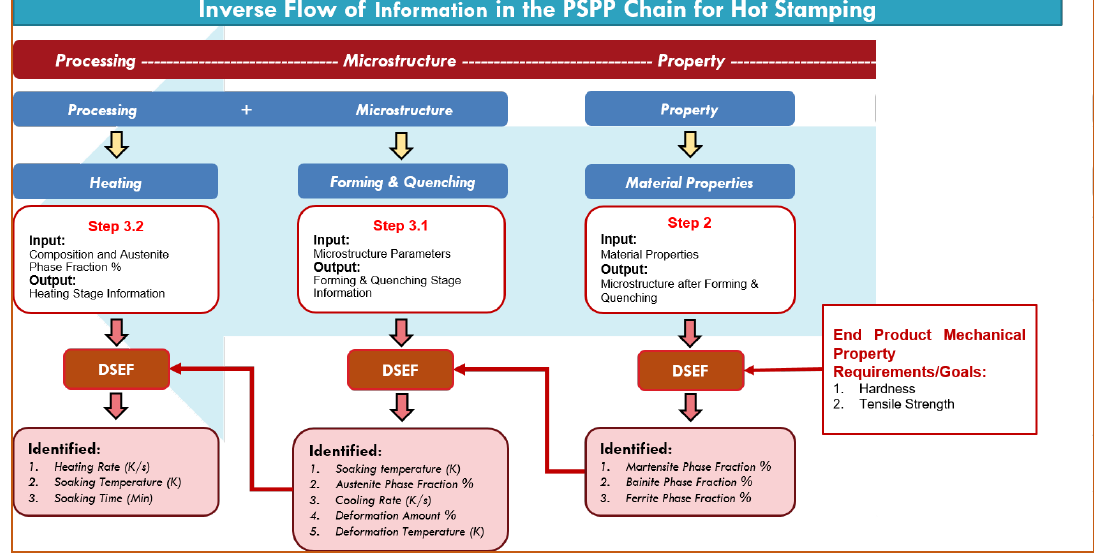
Figure 6. Inverse Flow of Information in Hot Stamping (step 1 skipped).